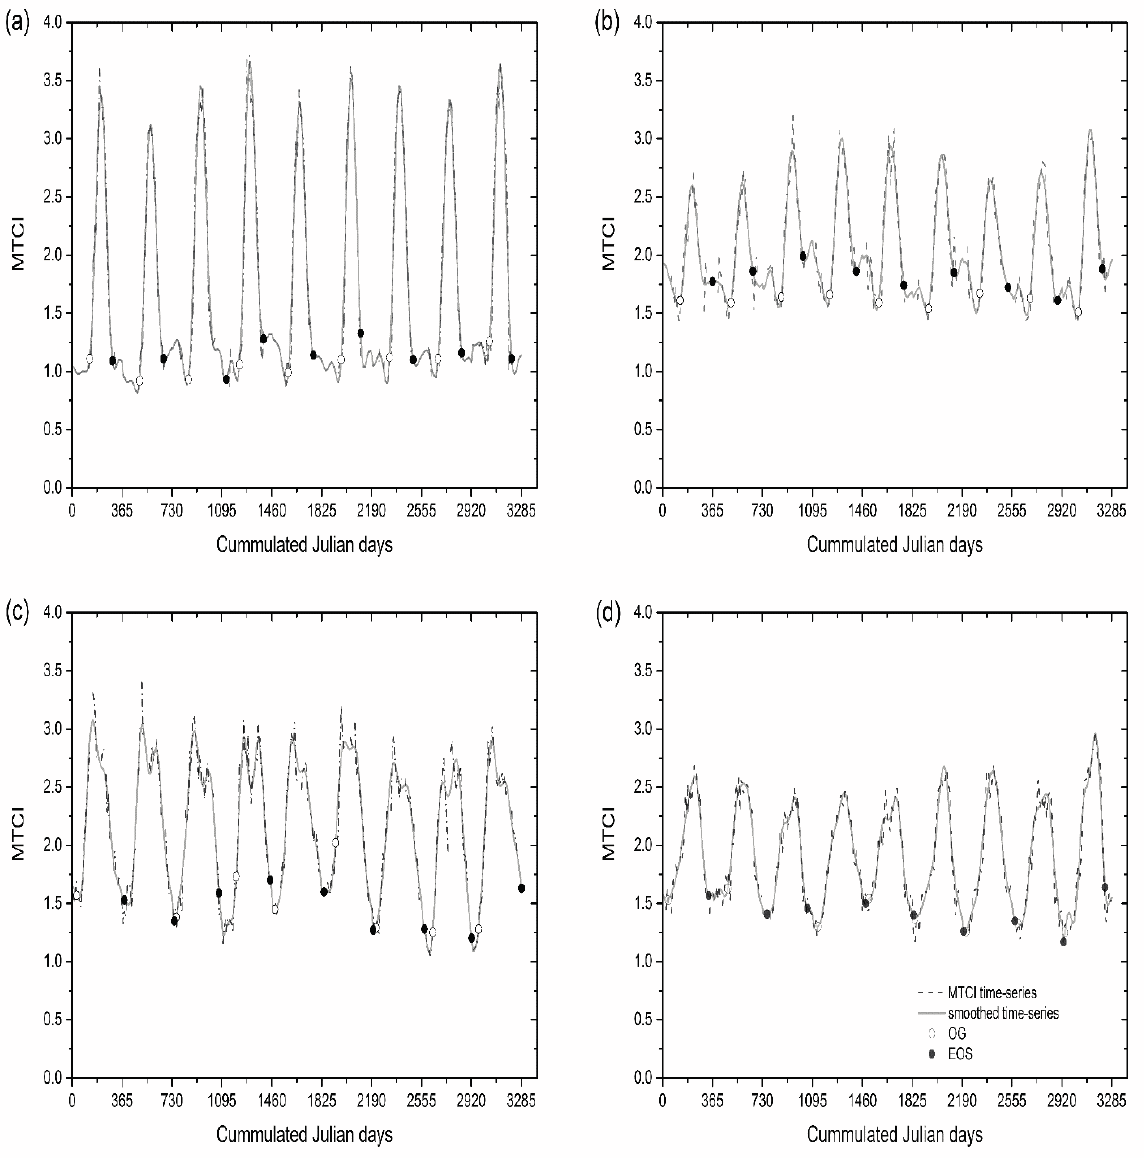
Figure 1. Inter-annual variation in MTCI values and phenology metrics for major natural vegetation types. ( a ) Broadleaved deciduous forests; ( b ) needleleaved evergreen forests; ( c ) grasslands; ( d )